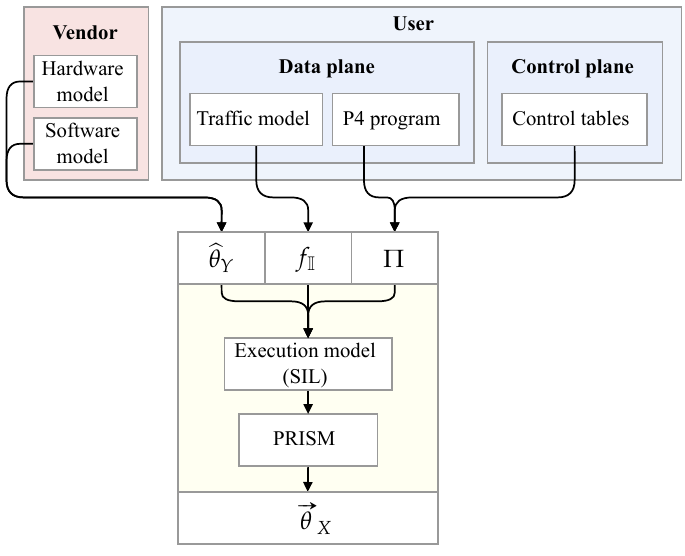
Figure 1. Overview of the cost analysis